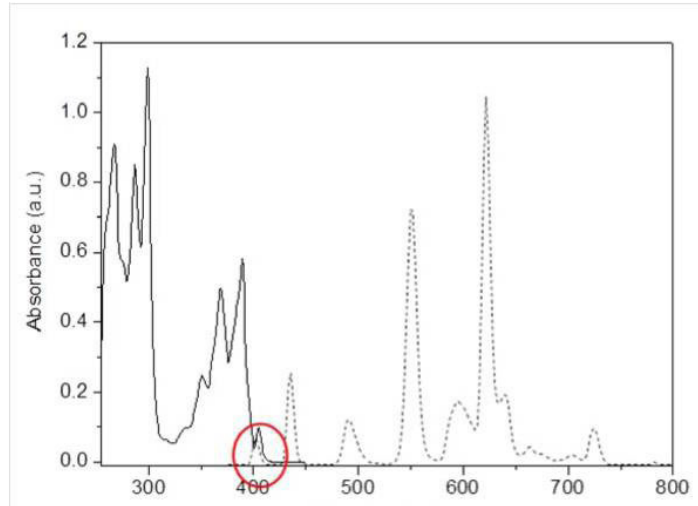
Figure 1. Absorption spectrum of BaP (solid line) and fluorescent lamp emission spectrum (dashed line); red circle – overlay of the BaP absorption spectrum and light source emission spectrum